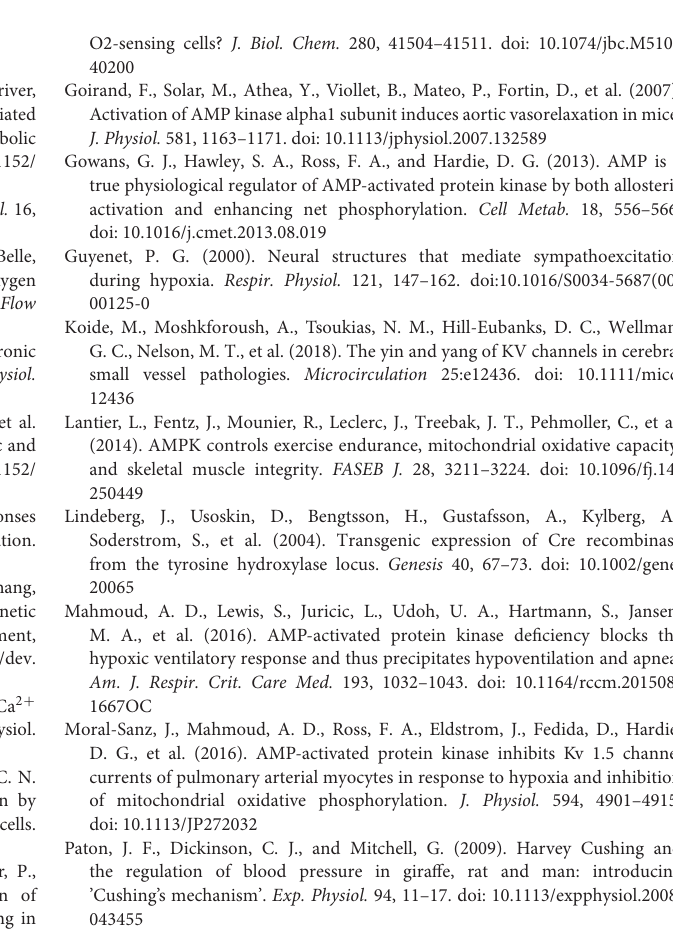
FIGURE S1 | End-point RT-PCR confirms AMPK deletion. End-point RT-PCR amplicons for transgelin and the catalytic α 1 and α 2 subunits of AMPK from lungs (right) and primary cultures of pulmonary arterial smooth muscle cells (PASMC, left) obtained from transgelin-Cre, C57BL6 (WT), AMPK- α 1 and AMPK- α 2 knockout mice. FIGURE S2 | Deletion of AMPK- α 1 or AMPK- α 2 subunits in smooth muscles does not attenuate the HVR and has no effect on either apnea duration index or systemic arterial blood pressures during hypoxia. Box plots show the median (solid line), 25 th to 75 th percentiles (boxes), mean ( + ) and whiskers according to Tukey’s method for: the % change of the ventilatory components of (Ai) breathing frequency, (Aii) tidal volume, and (Aiii) minute ventilation during the initial Augmenting Phase (A), the Roll-Off (RO), and the Sustained Phase (SP) of the hypoxic ventilatory response; (Bi) the apneic index (per minute), (Bii) apnea durations (in msec) and (Biii) apnea duration index (frequency x duration); Mean, Systolic and Diastolic blood pressures (in mmHg) measured (Ci) at rest, (Cii) before, during, and after a 10 min hypoxic challenge, and (Ciii) as % change during hypoxia; arterial oxygen saturation (in %) during (Di) normoxia, 10 min hypoxia, and recovery, and (Dii) as % change during hypoxia and recovery. ∗ p < 0.05; ∗∗∗ p <